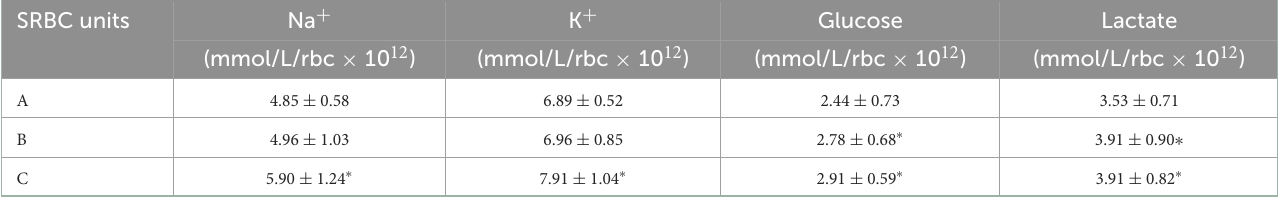
TABLE 1 The change rate of Na + , K + , glucose, and lactate in suspended red blood cells (SRBCs) during the whole storage period. SRBC units Na + K + Glucose Lactate (mmol/L/rbc × 10 12 ) (mmol/L/rbc × 10 12 ) (mmol/L/rbc × 10 12